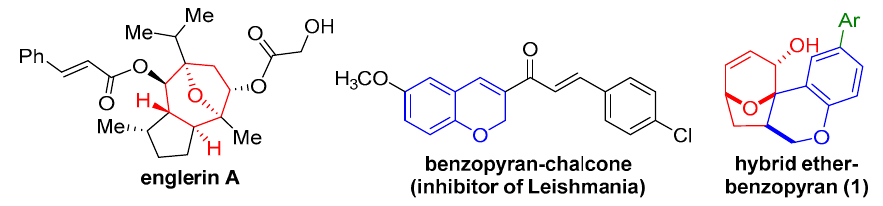
Figure 1. Hybrid polycyclic ether-benzopyran ( 1 ) .